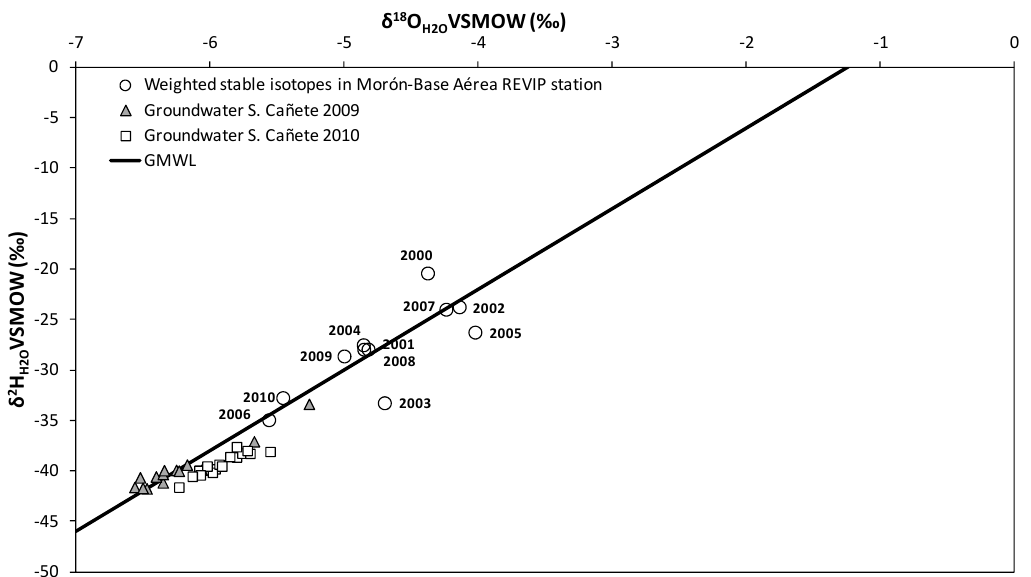
Figure 6. Isotopic results differentiated by field campaign and materials on which sampling points are located, with expansion in the 2010 sampling values (global meteoric water line (GMWL)). Samples from the carbonate area showed greater variation in δ 18 O and δ 2 H in 2010. These results can be adjusted to fall on a line essentially parallel to the GMWL. This indicates a recharge with water with a different history from the samples in 2009, due to the various origins of precipitation and hydrogeological processes, as shown by the difference in the deuterium excess between the two sampling campaigns. Notably, 2009 was the last year of a dry period that began in 2004 (Figure 2), in